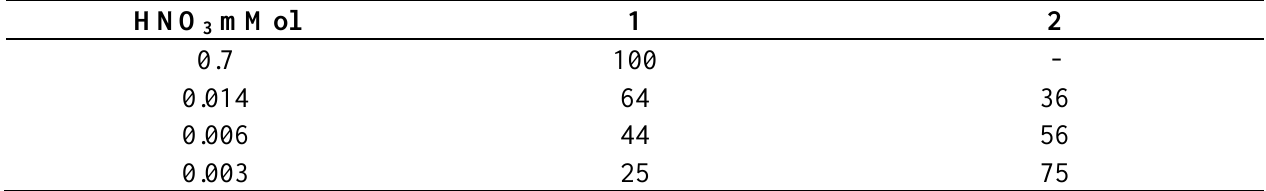
Table 2. The ratios of 1 to 2 as a function of HNO